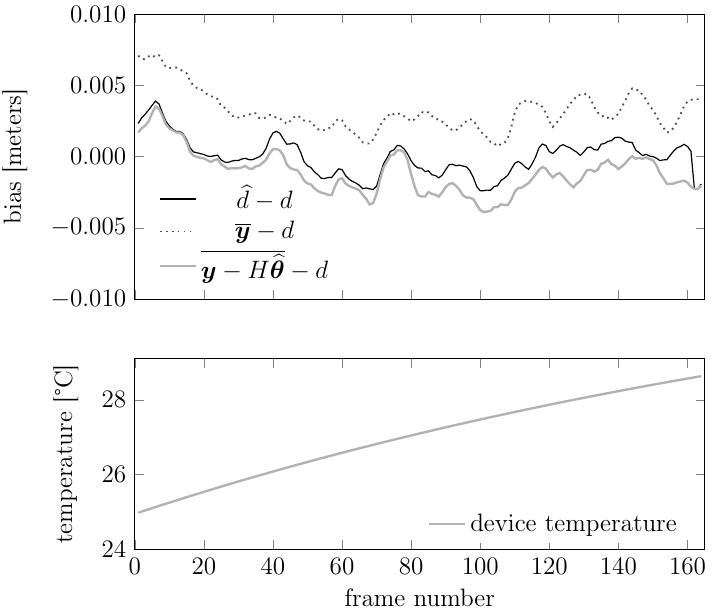
d , y and y H θ . In this − (cid:98)